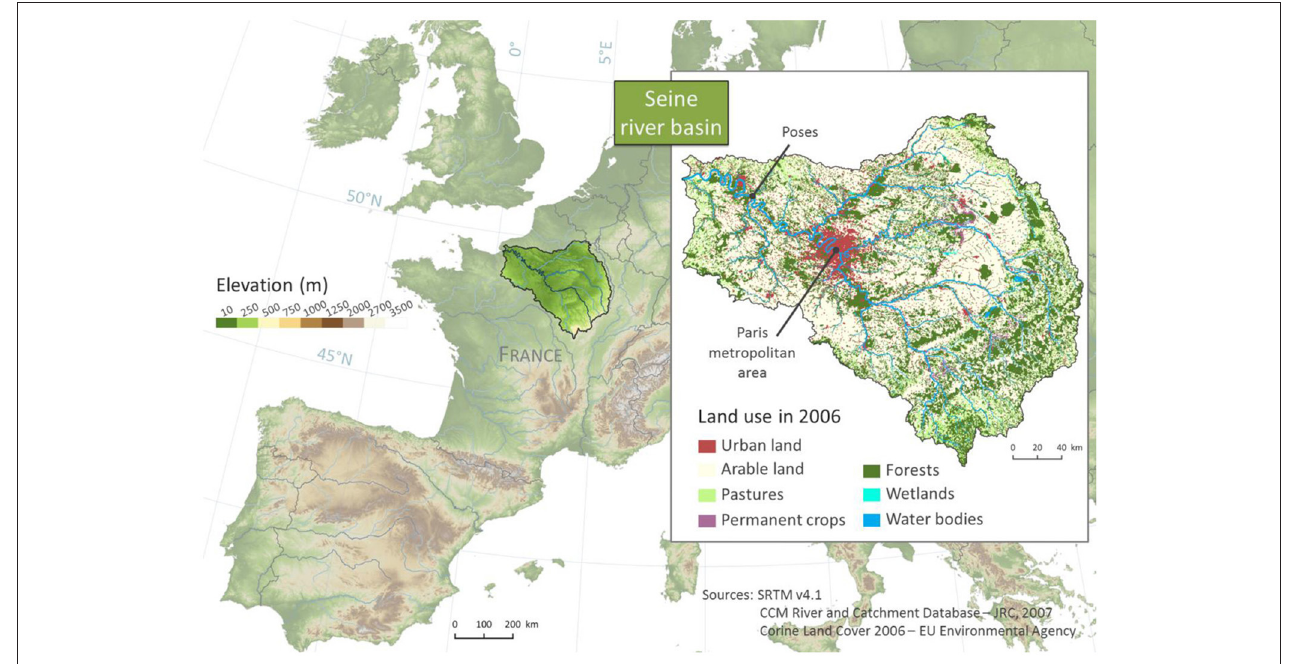
FIGURE 1 | Map of the Seine River network and basin, and land use in